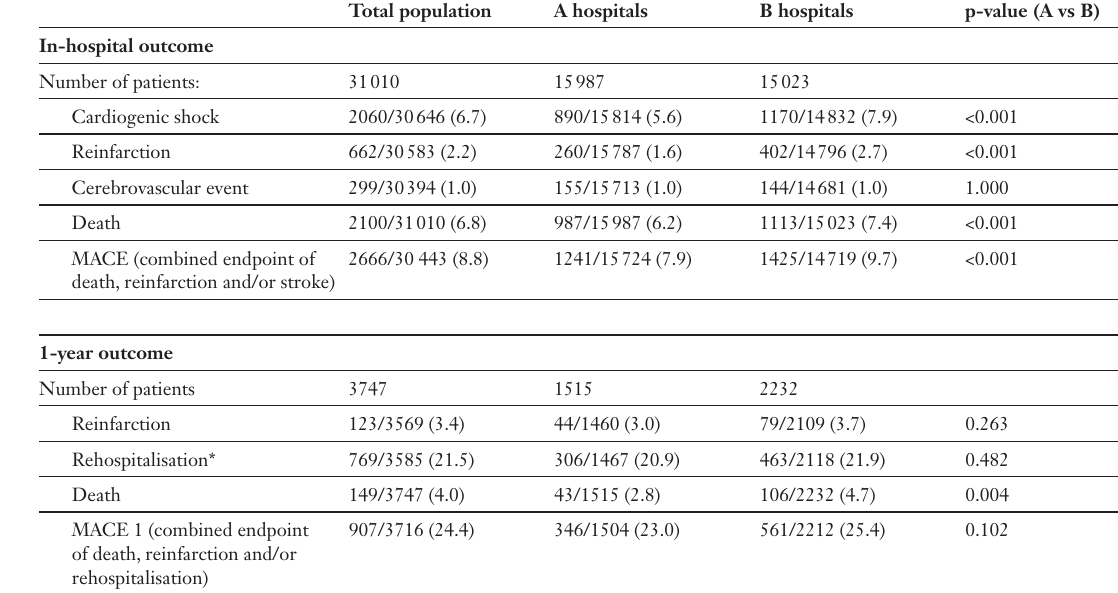
Complications and outcomes in ACS patients according to hospital type.